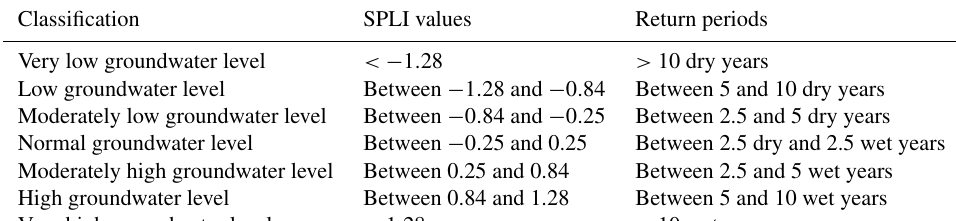
Table 3. Classification of water table level classes related to the values of the SPLI corresponding to the MHS limits.